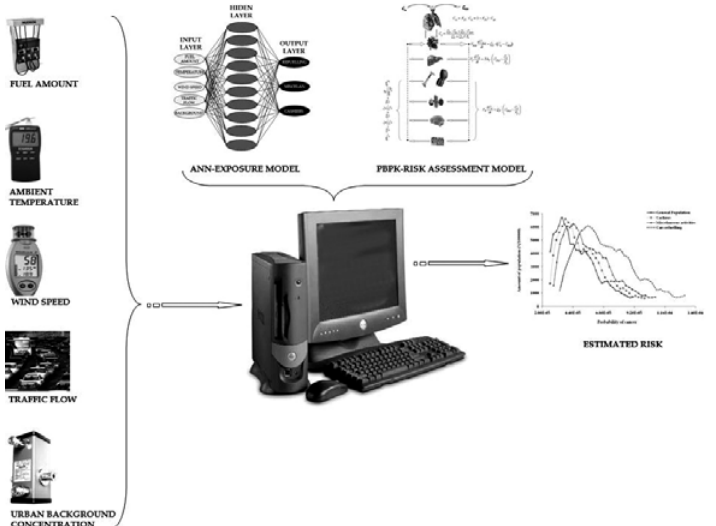
Figure 1 . Visual concept of the proposed exposure and risk assessment